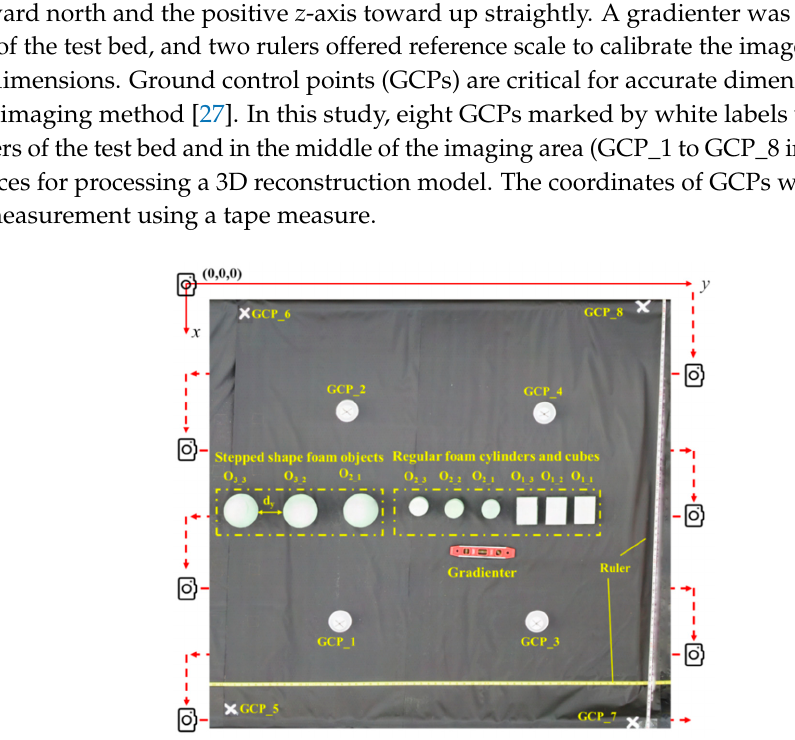
Table 1. Key parameters of experimental setup.